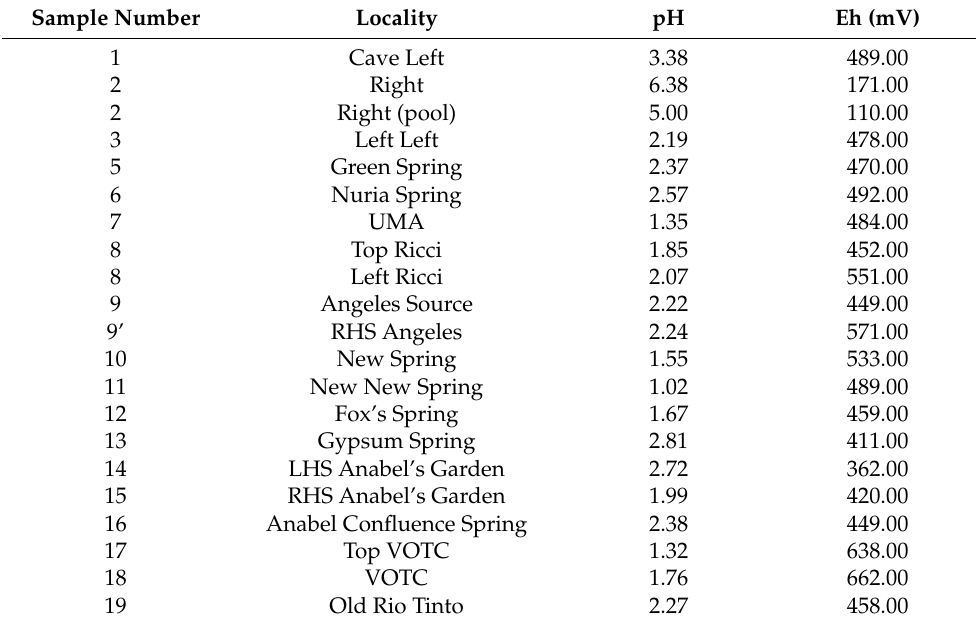
Table 2. pH and Eh (mV) of spring and stream